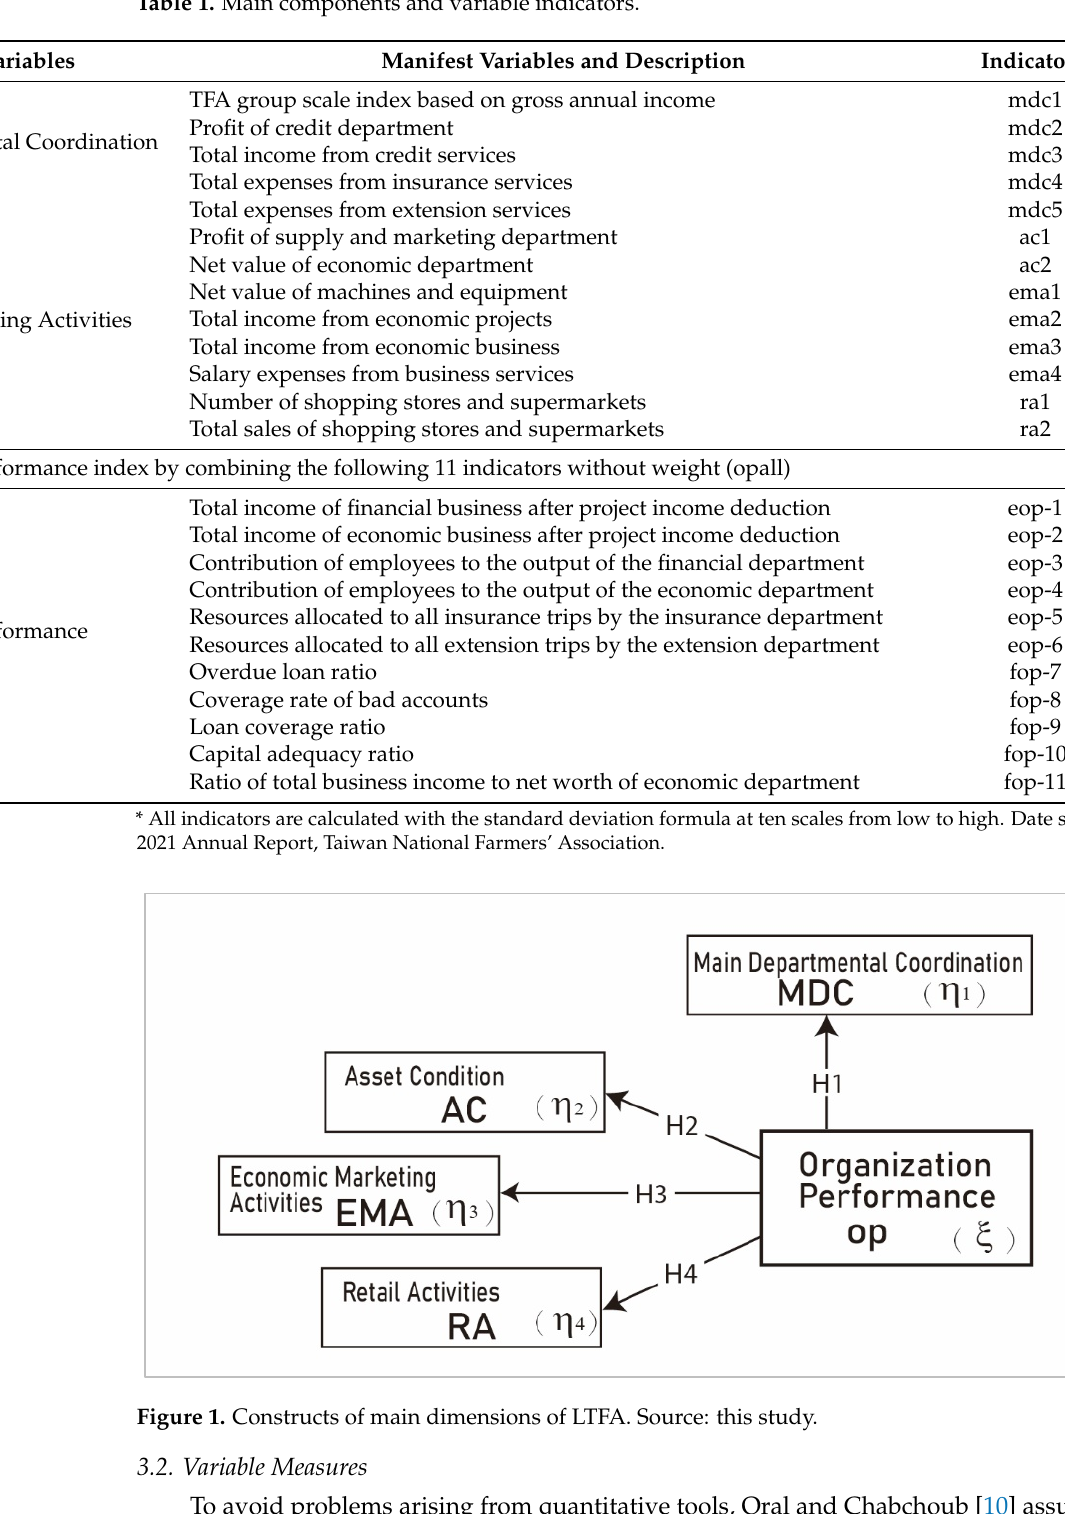
Table 1. Main components and variable indicators.